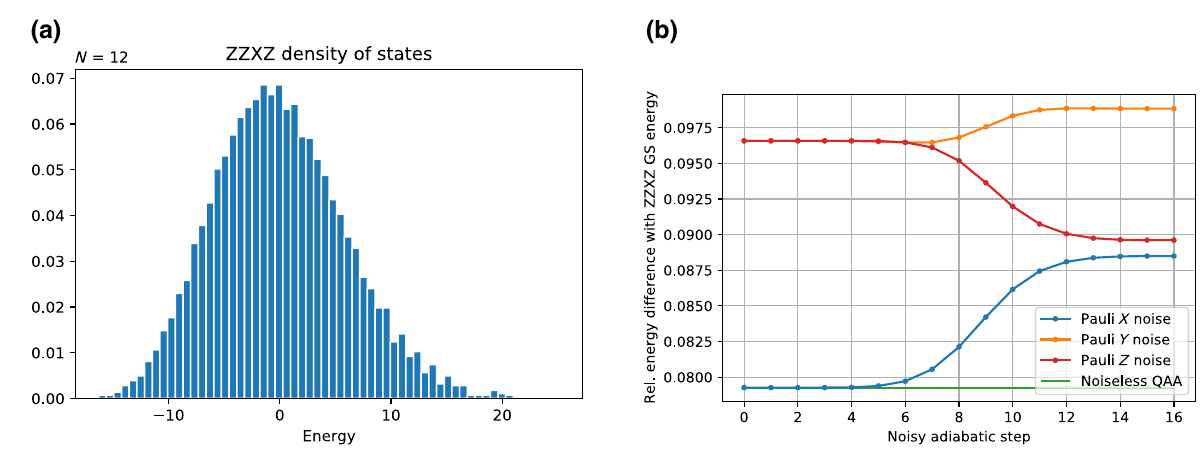
FIG. 21. Further plots on the robustness of the adiabatic evolution. (a) The energy density of states of the ZZXZ model for N = 12. Low-energy spectral lines are rare for physical instances. (b) The relative energy difference with the ZZXZ ground state, obtained using DMRG methods for adiabatic ground-state preparation. The total time is fixed to T = 1, corresponding to 16 discrete adiabatic steps. Pauli noise is applied either before the first unitary (step 0) or after each unitary to the center qubit of the spin chain. We observe that there is no qualitative difference regarding the position in the adiabatic path at which noise occurs. Note that for a σ x noise gate, there is no difference in the energy at the beginning of the adiabatic path because the initial Hamiltonian H 0 commutes with σ x . | 2 (apart from the number of measurements needed using the Chernoff- For E 2 < 1 / 2, no nontrivial bound for | ψ 0 | ψ | 2 ∈ [0, 1]) can be given in the limit of very large K Hoeffding inequality (Fig. 20). For a discussion of the 0 inherent robustness of adiabatic algorithm, we show the (with this approach). energy density of states for N = 12 for the ZZXZ model [Fig. 21(a)] and an analysis of the relative energy error due to a noisy gate at different positions in the adiabatic evolution [Fig.